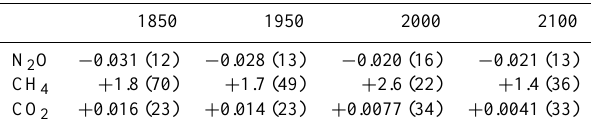
Table 3. Steady state 2-D model calculated percentage change in annual/global average total ozone per unit mixing ratio change for the compounds and years listed. The mixing ratios are in parts per billion by volume (ppbv) for N 2 O, and parts per million by volume (ppmv) for CH 4 and CO 2 . Shown in parentheses are the percent- age changes of each compound, relative to the background levels, required to produce a 1% ozone change.